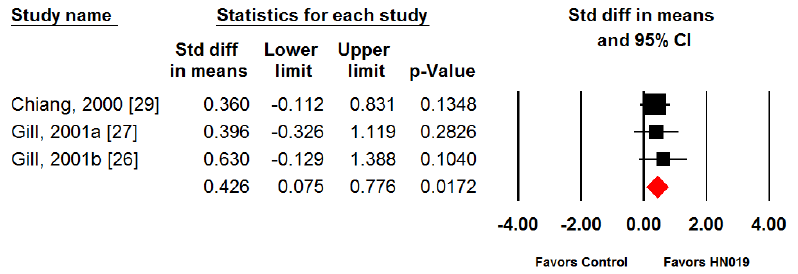
Figure 3. Forest plot of natural killer (NK) cell tumoricidal activity with consumption of B. lactis HN019 vs. control. Random effects meta ‐ analysis using the standardized mean difference (SMD) statistic. The SMD of B. lactis HN019 relative to control is plotted for each study. A pooled estimate of SMD (diamond) and 95% confidence interval (diamond width) summarizes the effect size. Effects to the left of 0 indicate greater NK cell tumoricidal activity with control; effects to the right of 0 indicate greater activity with B. lactis HN019. When the horizontal bars of an individual study, or the pooled diamond width, cross 0, the effect is not significantly different. The pooled SMD was 0.43 (95% CI: 0.08 to 0.78, p = 0.02), representing a moderate treatment effect in favor of B. lactis